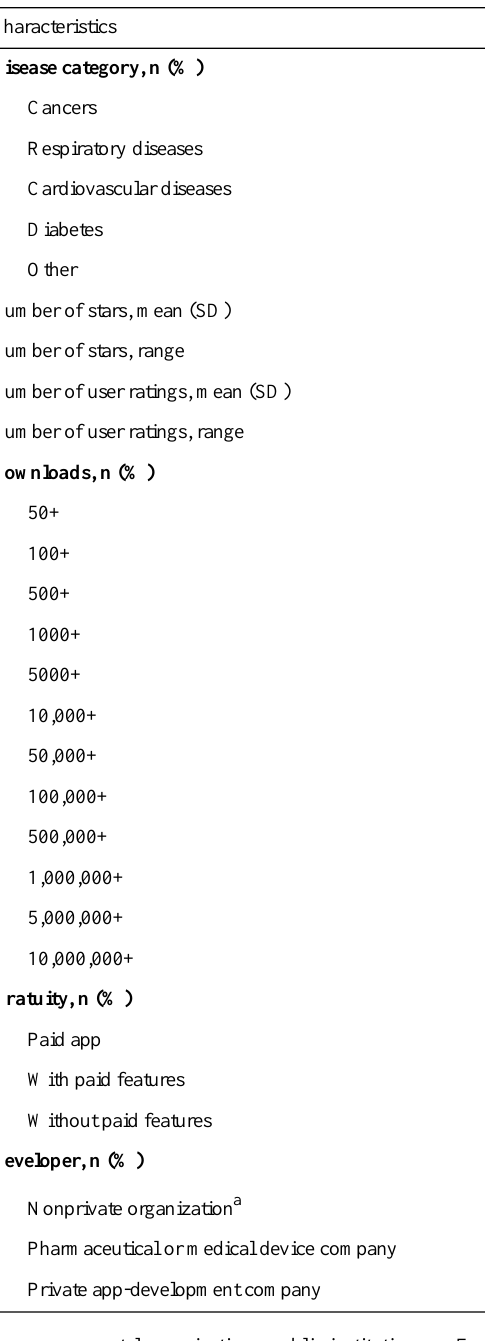
Table 1. Characteristics of apps